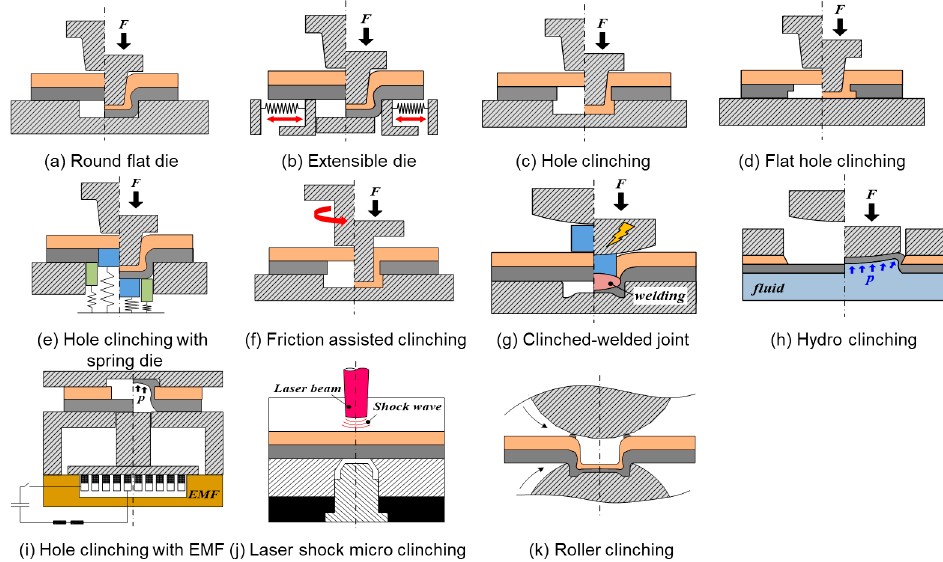
Figure 5. Various versions of mechanical clinching processes.